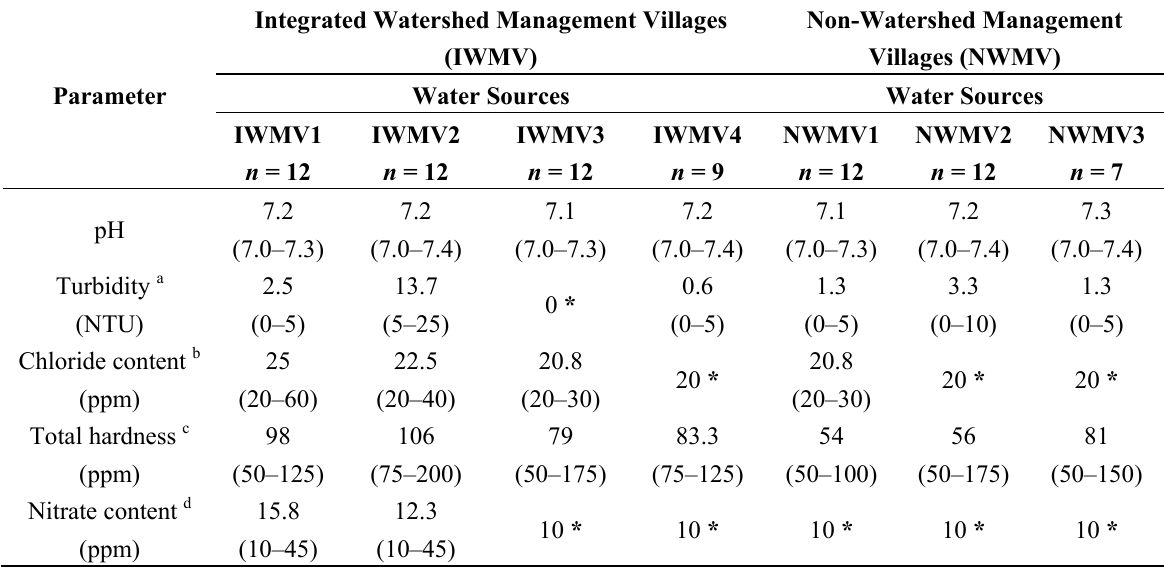
Table 1. Physico-chemical quality parameters (average/month) of water from each well of six tribal villages with and without implementation of integrated watershed management